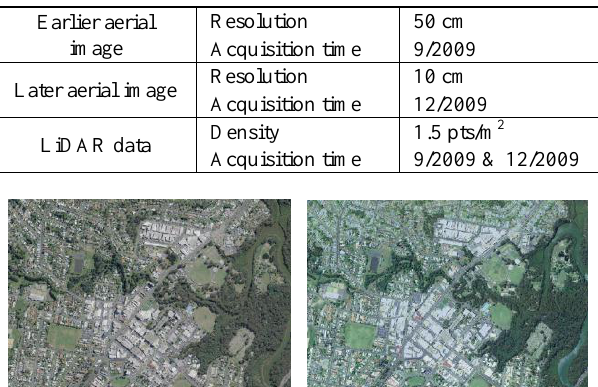
Table 1: Characteristics of aerial images and LiDAR datasets.